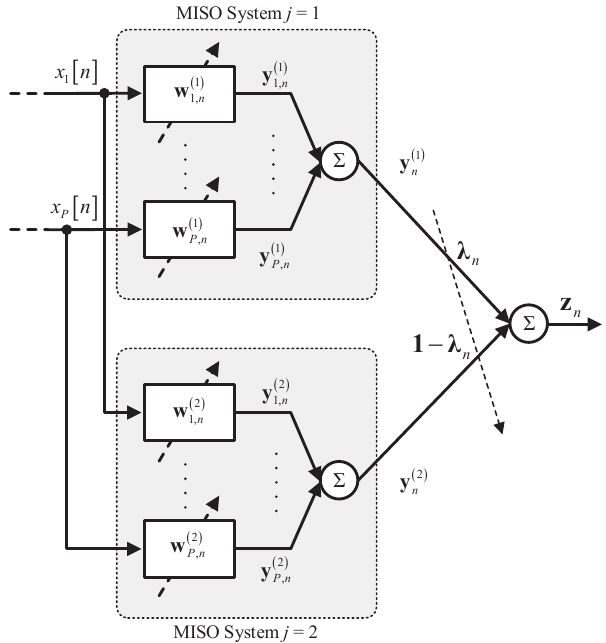
Figure 1. System-by-system combination scheme of two adaptive MISO